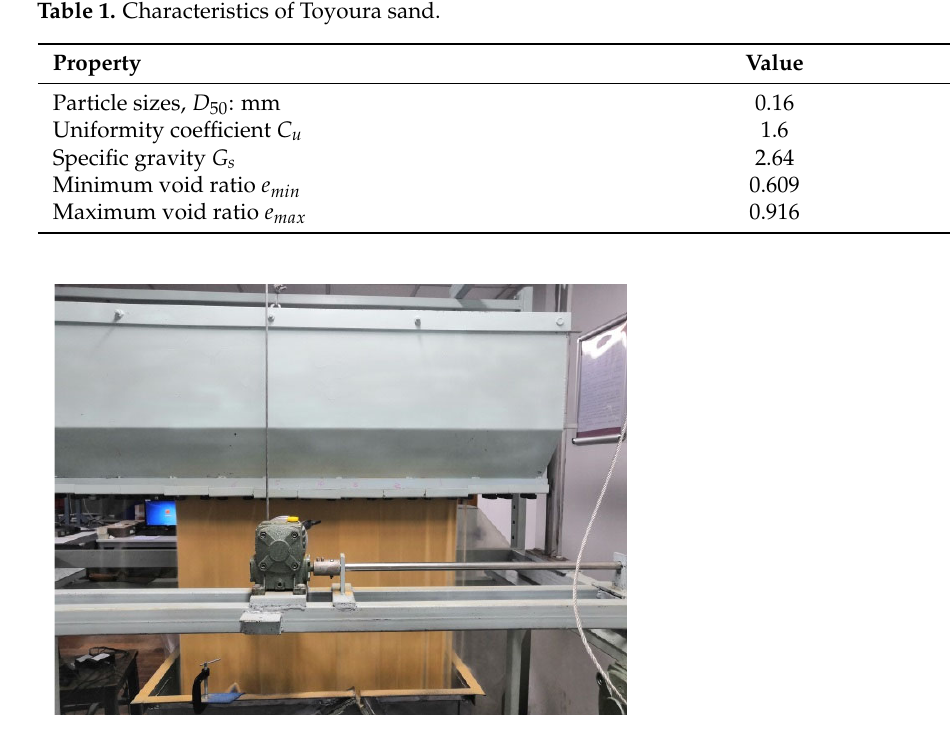
Figure 4. Raining Figure 4. Raining method.